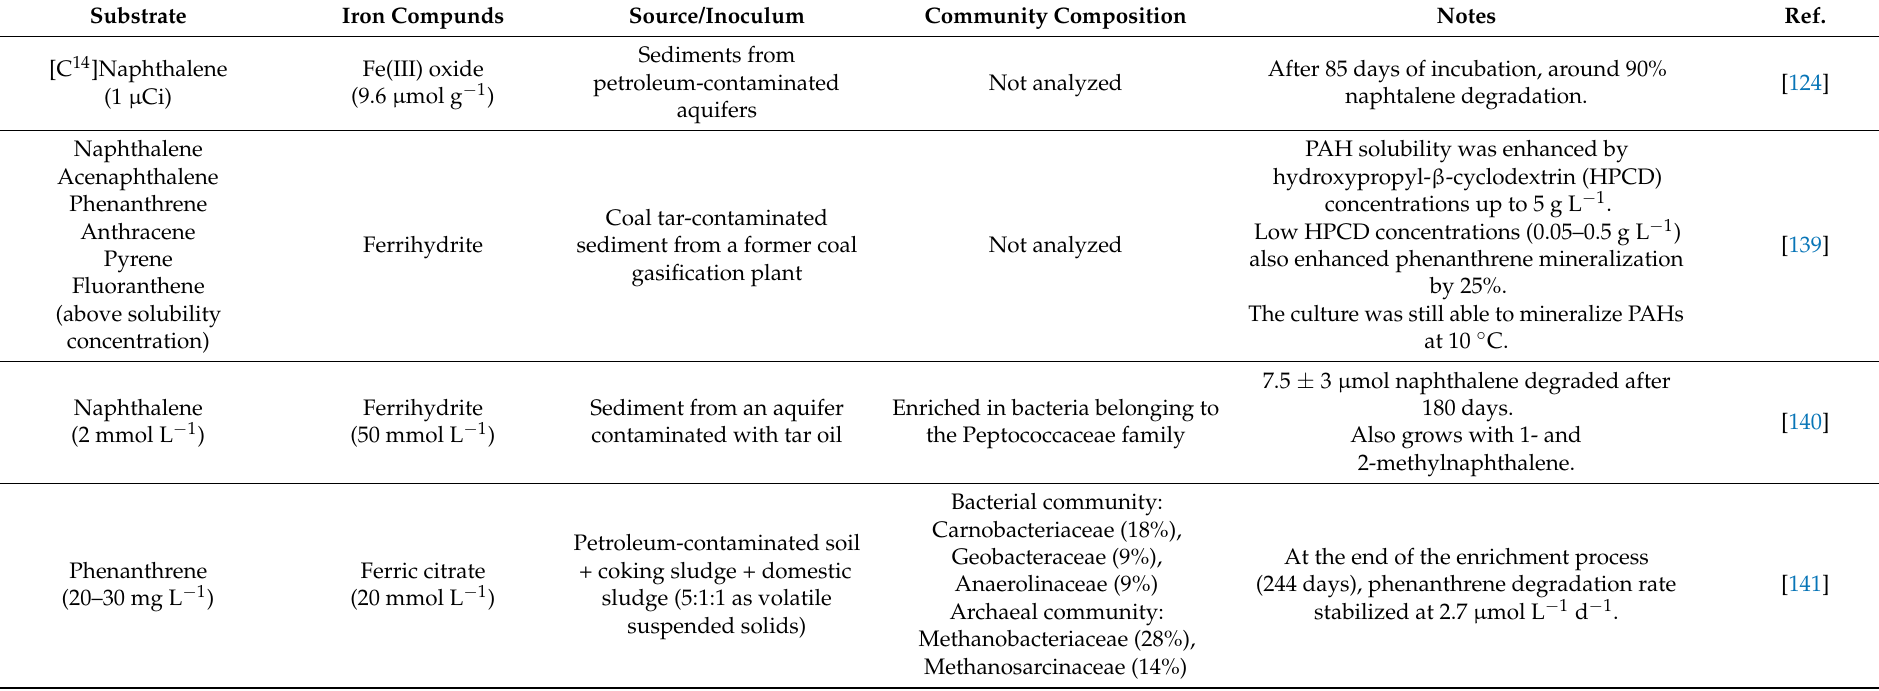
Table 4. Overview of PAH degradation coupled to Fe(III) reduction in microcosms and enrichment